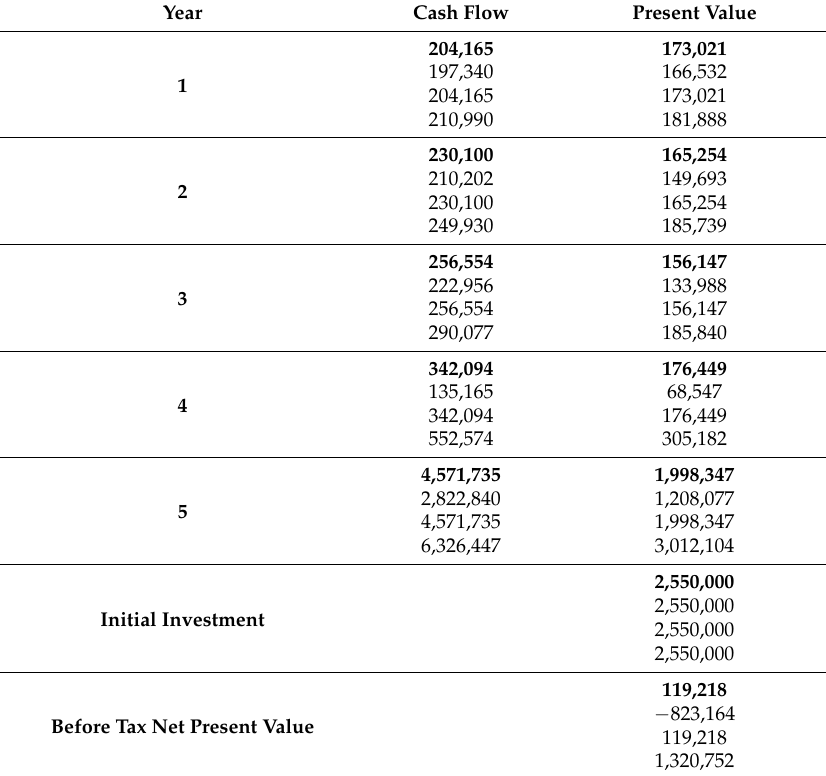
Table 10. Calculation of Before Tax Net Present